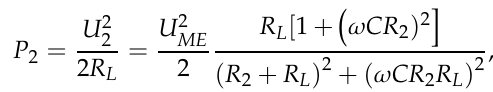
Figure 7. Simplified equivalent circuit of the output capacitive part of the ME transformer. U ME is the open-circuit magnetoelectric voltage; R 2 is the output resistance of the transformer, C is the output capacitance of the transformer, both connected in parallel; R L is the load resistance; U 2 is the measured voltage at the load resistor R L .